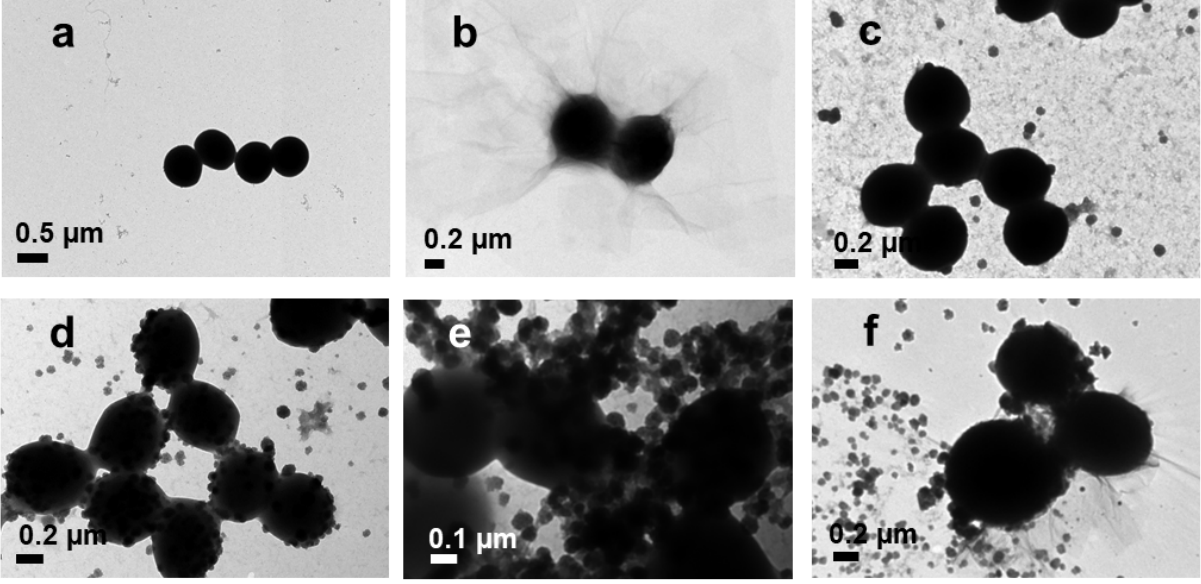
Figure 12. TEM images of S. aureus before ( a ) and after treatment with GO ( b ), Ag NPs ( c ), Ag NPrsms ( d ), GO–Ag NPs ( e ), and GO–Ag NPrsms ( f ).